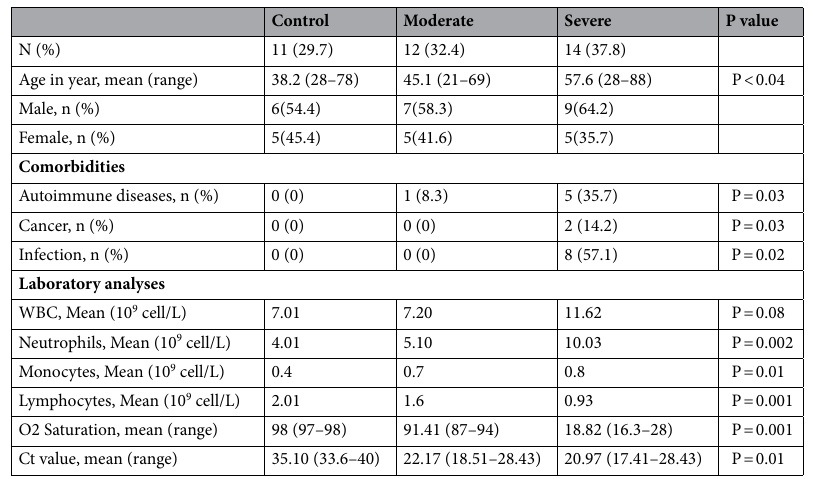
Table 2. Demographic and clinical characteristics of participant’s patients. *Lymphocyte count, Ct value; WBC and neutrophil, counts at the time point of the lowest lymphocyte count. Normal range: WBC 3.5 × 10 9 /L to 8.8 × 10 9 /L, lymphocytes 1.1 × 10 9 /L to 3.5 × 10 9 /L, neutrophils 1.6 × 10 9 /L to 5.9 × 10 9